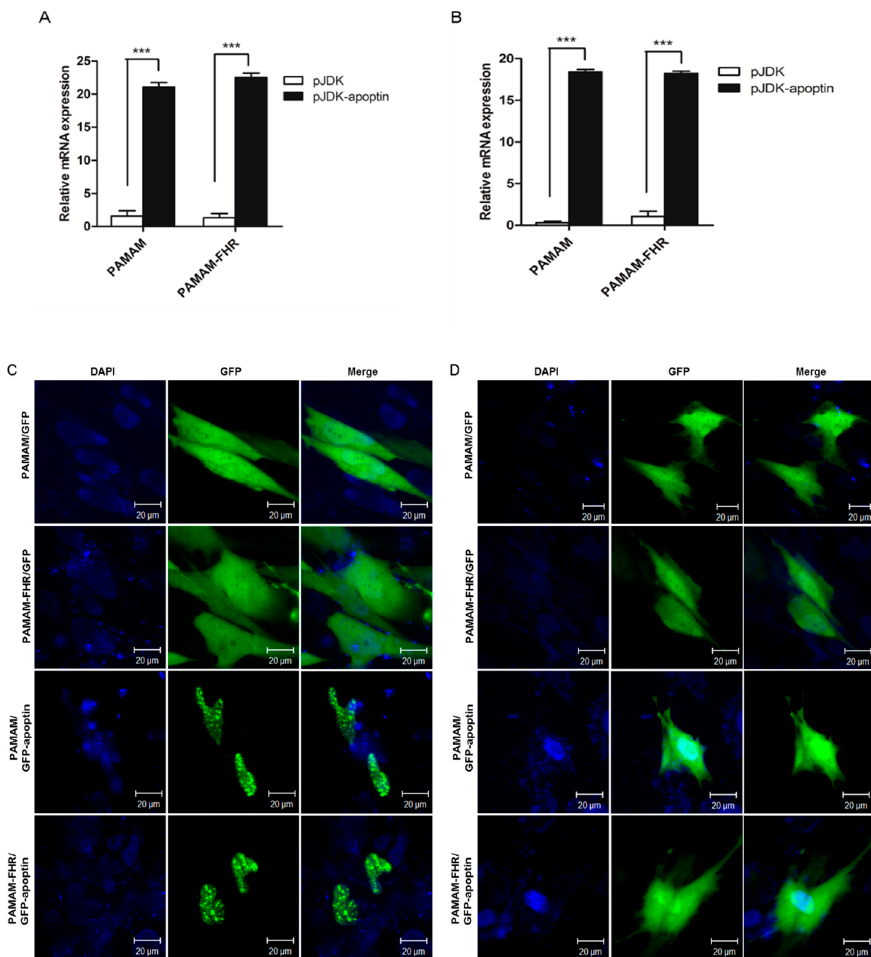
Figure 5. Induction of the apoptin gene expression by PAMAM-FHR. ( A ) GBL-14 and ( B ) dermal fibroblasts were expressed for 24 h with polymer/apoptin complexes at the weight ratio of 4. The expression of the apoptin gene was measured by quantitative Polymerase Chain Reaction (PCR) (q-PCR). Asterisks present statistically significant values. Unpaired t -test: *** p < 0.001. ( C ) GBL-14 and ( D ) dermal fibroblasts were incubated for 24 h with each polymer/GFP or GFP-apoptin complex and analyzed confocal microscopy.